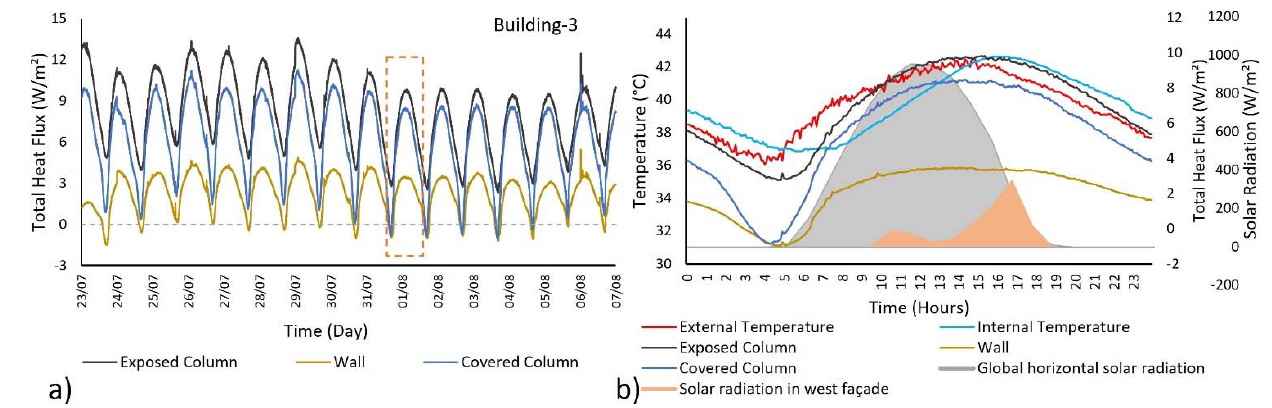
Figure 9. ( a ) Building-3 heat flux for the whole period and ( b ) selected day heat flux, external and internal temperature, and solar radiation.